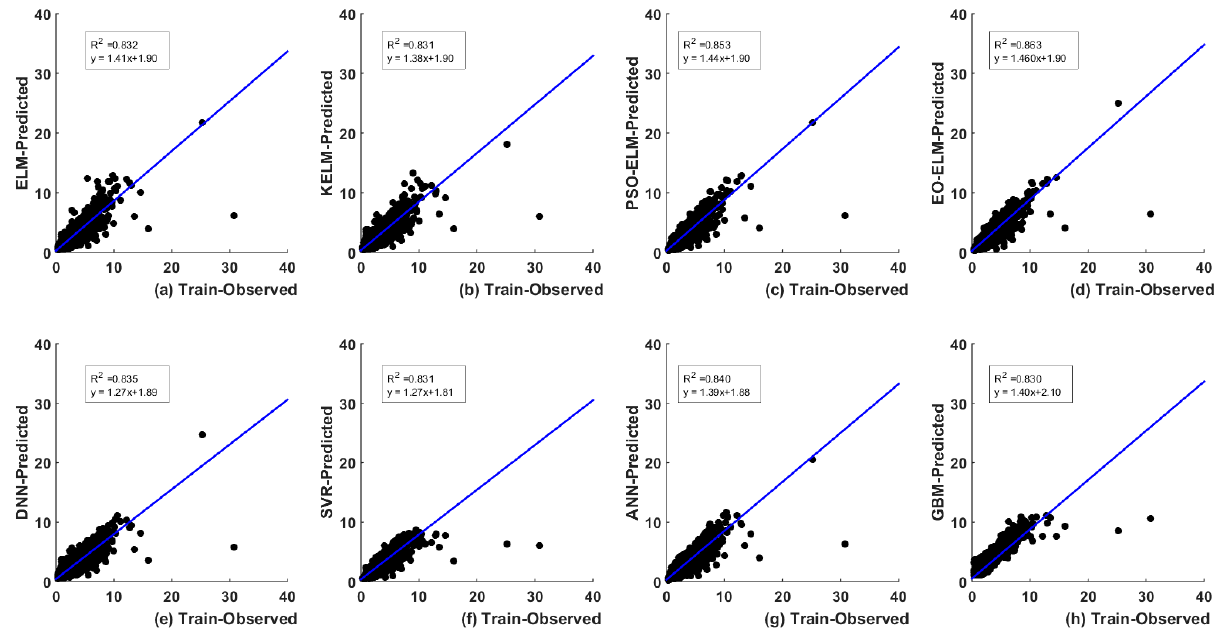
Figure 7. Prediction capability of the eight models in train case ( a ) ELM, ( b ) KELM, ( c ) PSO-ELM, ( d ) EO-ELM, ( e ) DNN, ( f ) SVR, ( g ) ANN, and ( h ) GBM for the catchment Fal at Tregony.